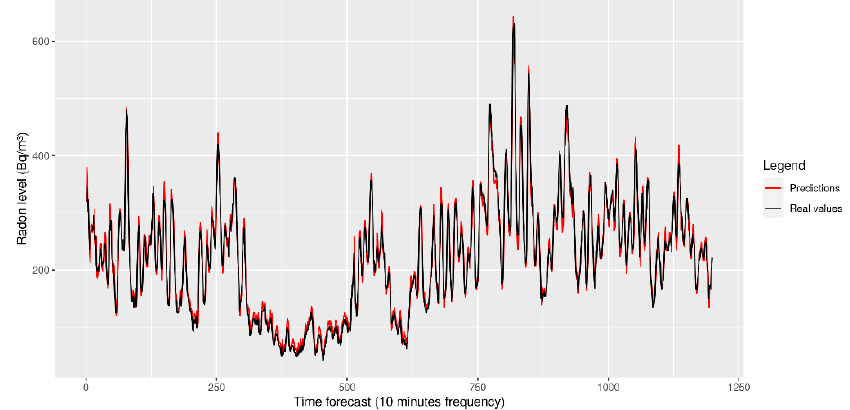
Figure 6. Best LSTM model.